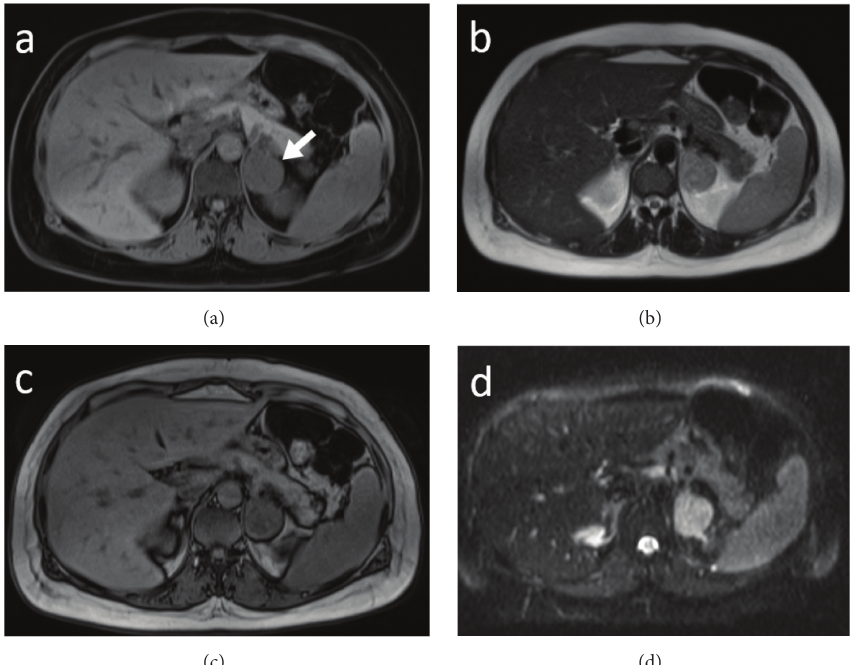
Figure 2: Axial T1-weighted (a) with fat suppression and T2-weighted (b) MR images show a left adrenal mass (arrow in (a)). The mass has heterogeneous high signal intensity on the T2-weighted image, low signal intensity on T1-weighted image, and no signal dropout on opposed phase T1-weighted image (c). Axial diffusion-weighted image (DWI) shows high signal intensity due to restricted diffusion (d).